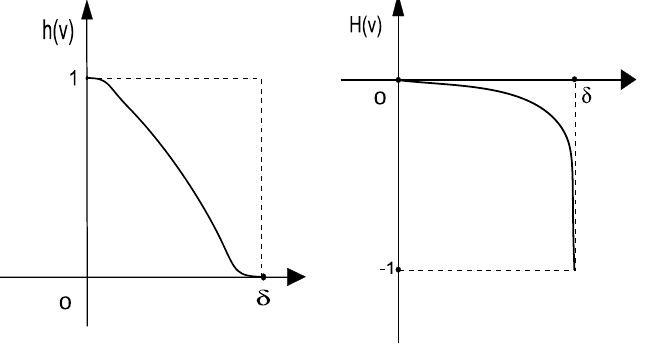
Fig. 4 – Transition function h and function H